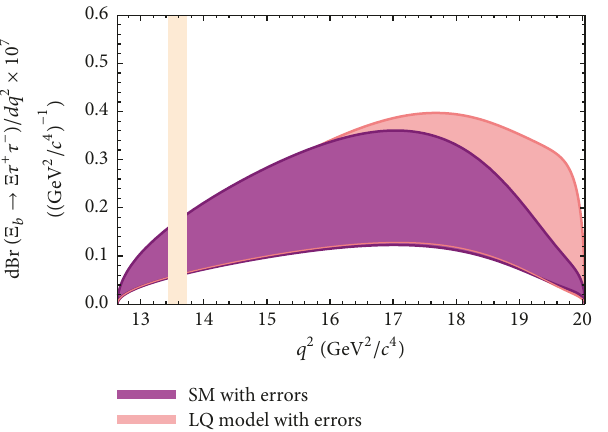
Figure 7: The dependence of the A FB on 𝑞 2 for the Λ 𝑏 → Λ𝜇 + 𝜇 − transition in the SM and LQ models. The experimental data are taken from the LHCb Collaboration [2]. The lattice predictions are borrowed from [31]. The vertical shaded bands indicate the charmonia veto regions.